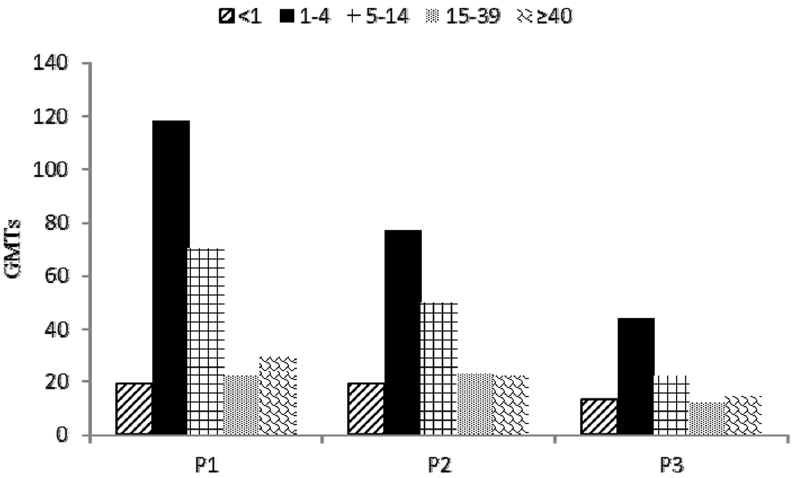
Figure 3. GMTs of P1, P2 and P3 by age group in southern Xinjiang Uygur Autonomous Region before SIAs, 2011. Note: P1: poliovirus serotype 1; P2: poliovirus serotype 2; P3: poliovirus serotype